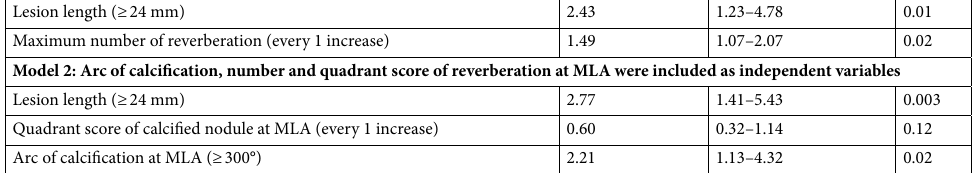
Table 4. Multivariate logistic regression model to find factors associated with slow flow dependent variable: Slow flow (≤ TIMI-2) just after RA. Multivariate stepwise logistic regression model to evaluate the association between IVUS findings and slow flow just after RA. Variables that had a significant association (p < 0.05) between the 2 groups were used as independent variables. Two models were shown since angle of calcification, the number and quadrant score of reverberation from all frames and MLA can lead to multicollinearity. The model 1 and 2 commonly included minimal lumen area (≥ 1.8 mm 2 ), lesion length by IVUS (≥ 24 mm), and quadrant score of calcified nodule at MLA (every 1 increase). In the model 1, maximal angle of calcification (≥ 360°), maximal number and quadrant score of reverberation (every 1 increase). In the model 2, angle of calcification (≥ 300°), and number and quadrant score of reverberation at MLA (increase 1). The multivariate logistic regression analysis with Wald Statistical criteria using backward elimination methods was performed. CI confidence interval, IVUS intravascular, MLA minimal lumen area, OR odds ratio, RA rotational